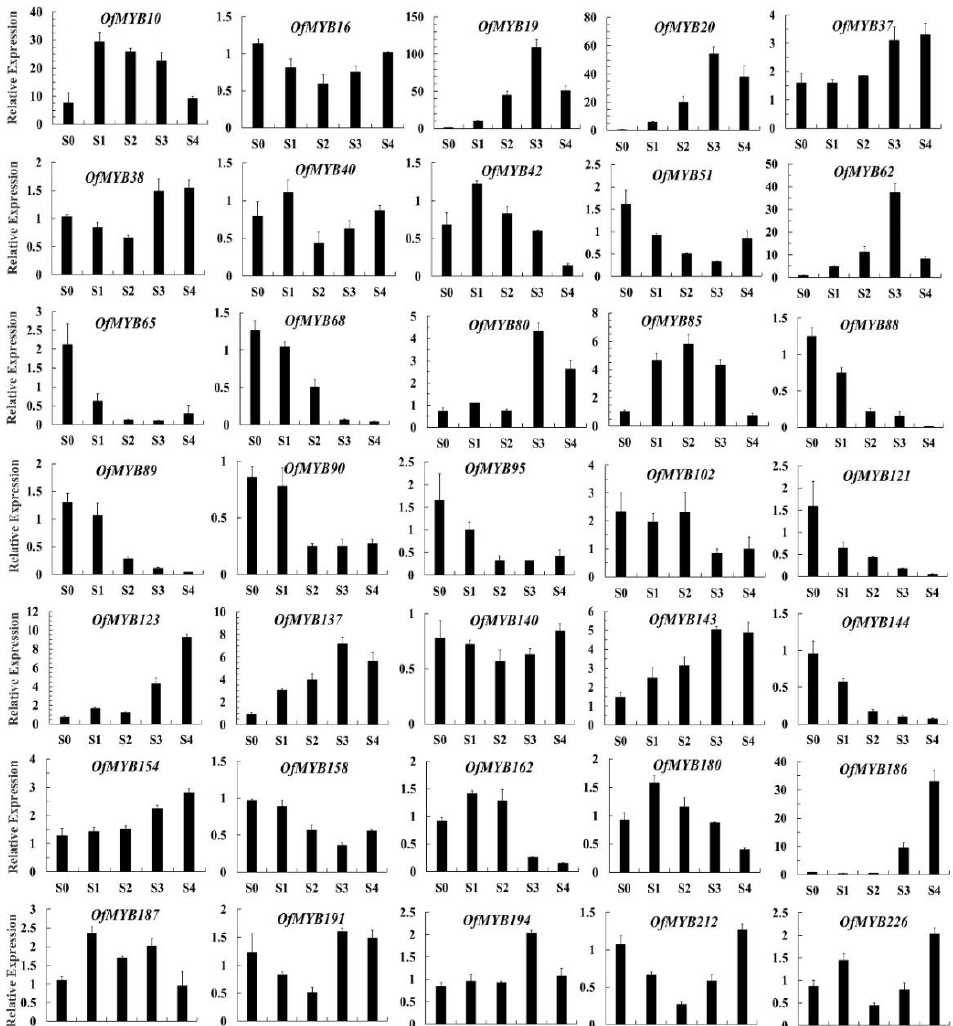
Figure 4. Expression analysis of selected MYB genes using qRT-PCR and gene expression of OfMYBs. S0-S4 correspond to five di ff erent flowering stages: bud-pedicel stage (S0), bud-eye stage (S1), initial flowering stage (S2), full flowering stage (S3), and final flowering stage (S4). The x-axis represents the di ff erent flowering stages and the y-axis the RPKM values. Data were normalized to the OfRPB2 expression level. The standard deviations of three biological replicates are represented by the error bars.